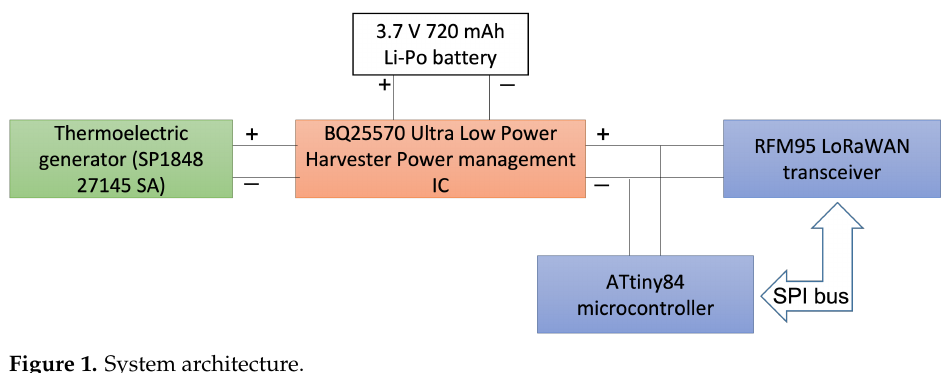
Figure 1. System